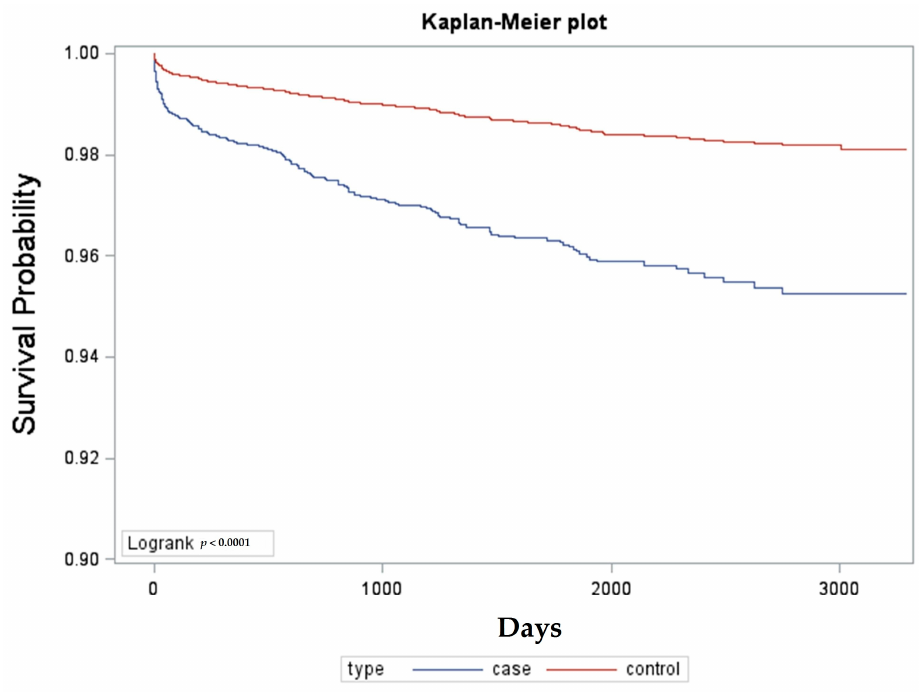
Figure 1. Kaplan–Meier Survival analysis of AAU patients against AS-free time.